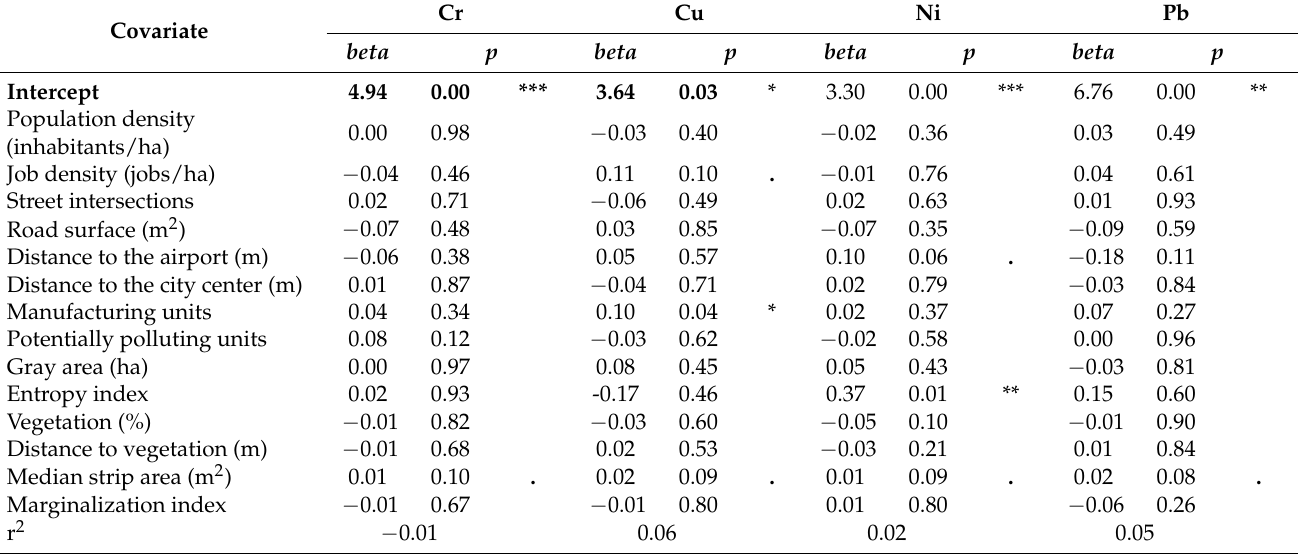
Table 5. Results of the ordinary least squares